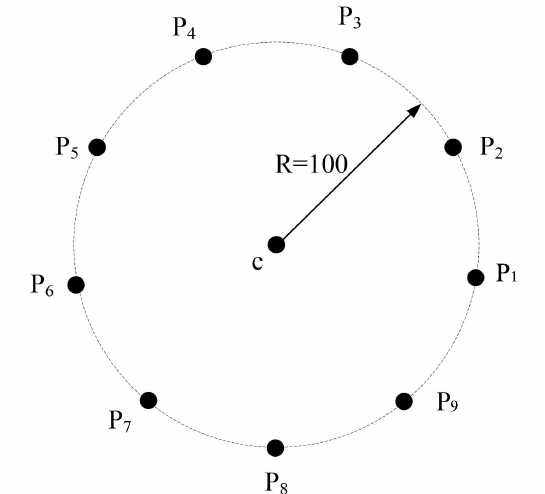
Figure 2. Desired uniform circle on a plane.